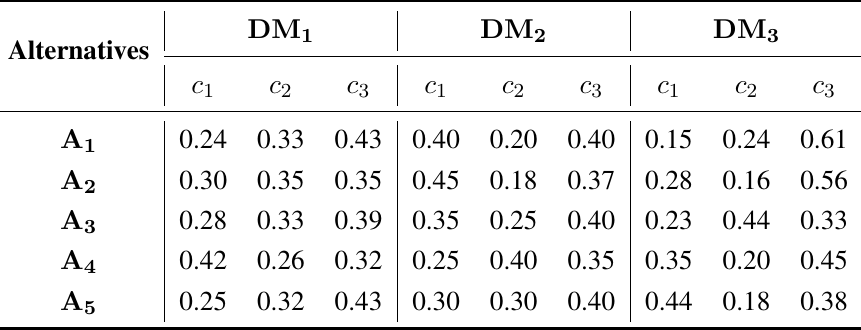
Table 2. Score matrices.